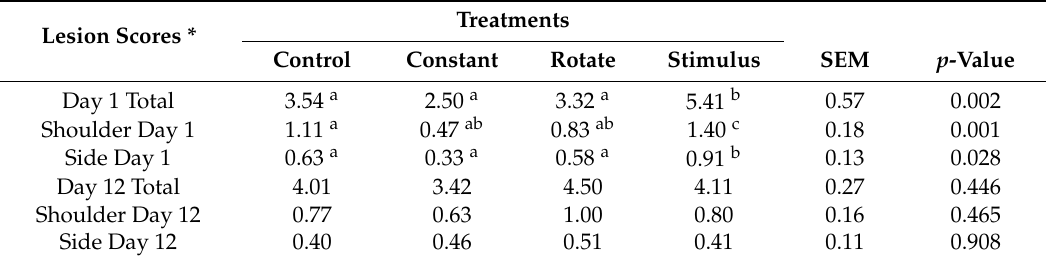
Table 7. E ff ects of enrichment treatments on skin lesion scores in focal sows. Lesion scores were measured on day 1 (before enrichment) and day 12 of each treatment period.